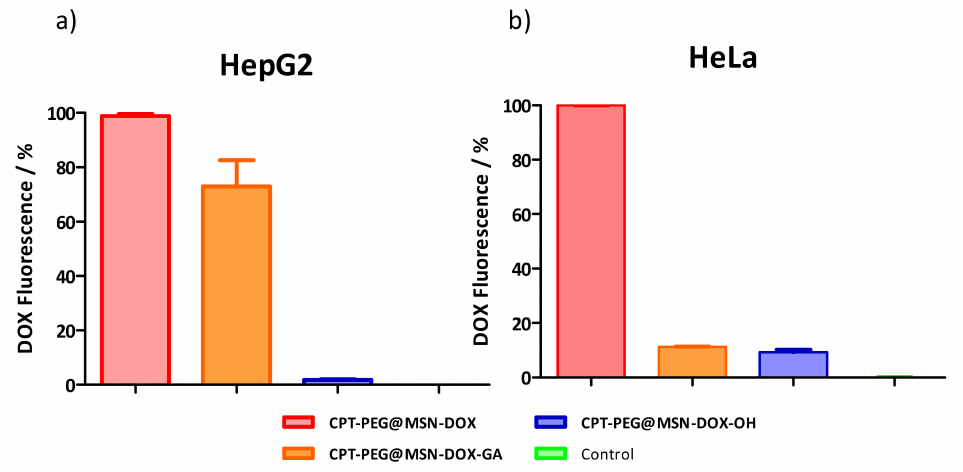
Figure 4. Flow cytometry analysis of HepG2 cells ( a ) and HeLa cells ( b ) incubated with 100 µ g · mL − 1 . Untreated cells were used as control. Data represented as mean ± SD ( n =